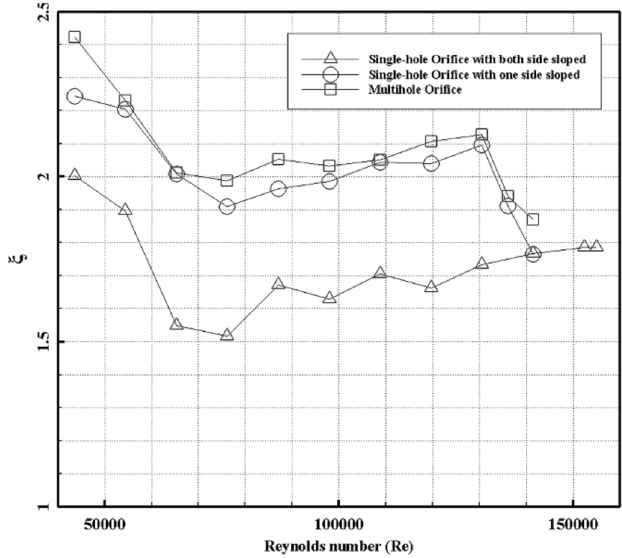
Fig. 14. Comparison of the pressure loss coef fi cient trend against the Rein a multi-hole ori fi ce, a single ­ -hole ori fi ce with a two-sided sloped edge and a single-hole ori fi ce with a one-sided sloped edge.